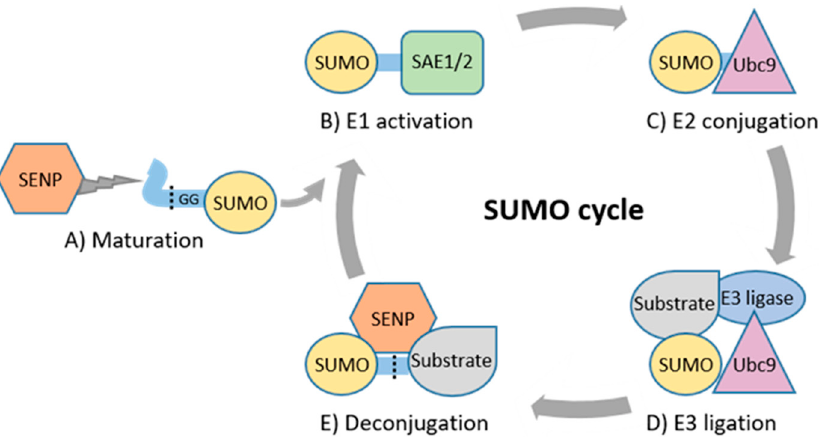
Figure 1. The enzymatic SUMO cascade. ( A ) SENPs cleave off amino acids from precursor SUMO to produce a mature SUMO. ( B ) SAE1/SAE2 forms of a thioester bond between SUMO’s GG and catalytic cysteine residue of SAE1/2. ( C ) Thioester bond is formed between SUMO’s GG and catalytic cysteine residue of Ubc9. ( D ) Ubc9 catalyzes formation of an isopeptide bond between GG and target substrate’s lysine residue often with assistance of an E3 ligase. ( E ) SENPs deconjugate SUMO from the substrate.